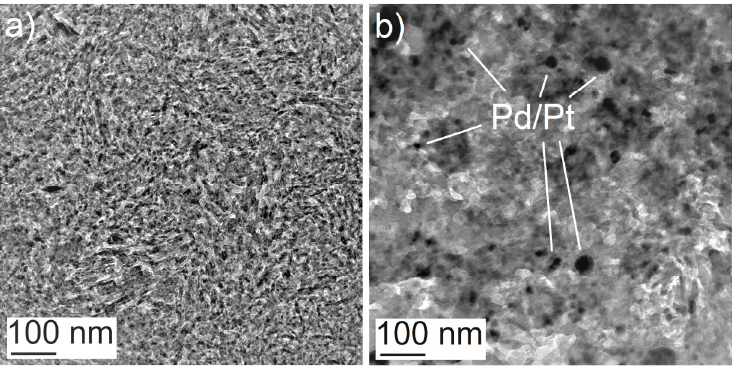
Figure 16. The cross-sectional TEM image of ( a ) the fresh natural gas catalyst and ( b ) the vehicle-aged inlet natural gas catalyst.